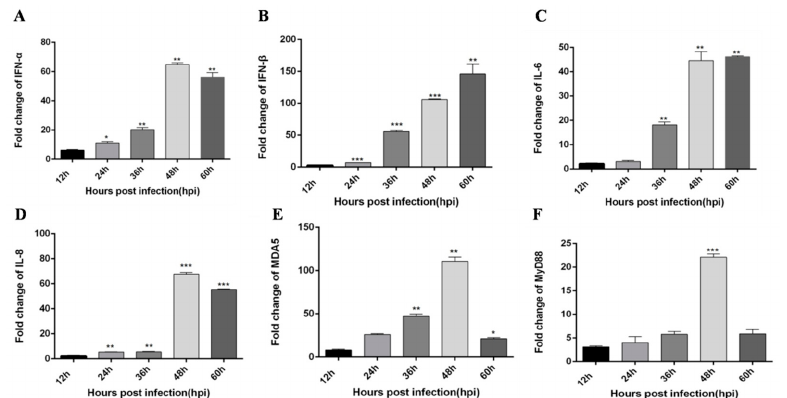
Figure 7. DTMUV-infected ducks effectively up-regulate IFN- α , IFN- β , IL-6, IL-8, MDA5, and MyD88